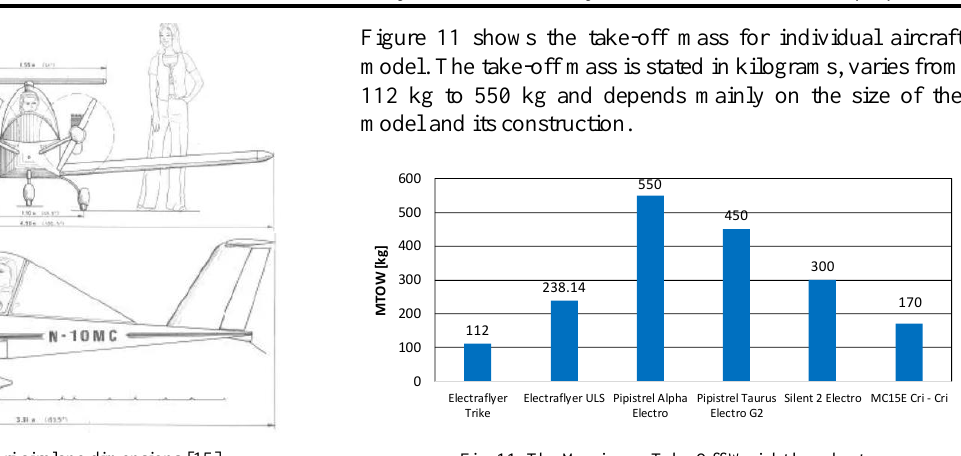
Fig. 10. MC-15 Cri-Cri airplane dimensions [15] Fig. 11. The Maximum Take Off Weight bar chart The Pipistrel Alpha Electro has the largest MTOW from all the aircrafts mentioned (Fig. 11). It’s 550 kg. Its take-off mass is justified by its size – it is the largest of the models discussed and belongs to ultralights which distinguishes it from other moto-hang gliders or motor gliders. The second model with a big take-off weight is the motor glider, by the same manufacturer – Taurus Elelctro G2. It has a take-off weight of 450 kg. Silent 2 Electro, also a glider, created by the Alisport manufacturer, is the next aircraft with a slightly Table 1. Comparison of aircrafts models according to parameters available lower take-off weight. It is slightly smaller than the Pipi- strel motor glider – the difference in the wingspan is about Aircraft model 1.5 meters. The next motif is Electraflyer ULS, whose MTOW is 283 kg, while the weight of an empty aircraft is 111 kg. The MC-15E Cri-Cri model has a take-off weight of 170 kg. The plane itself weighs 80 kg, and is the smallest of the aircraft in question with a wingspan of about 5 me- ters. The lightest among the discussed ones, is the ultra- light Electrafyler Trike. The take-off weight of the hang glider is less than 113